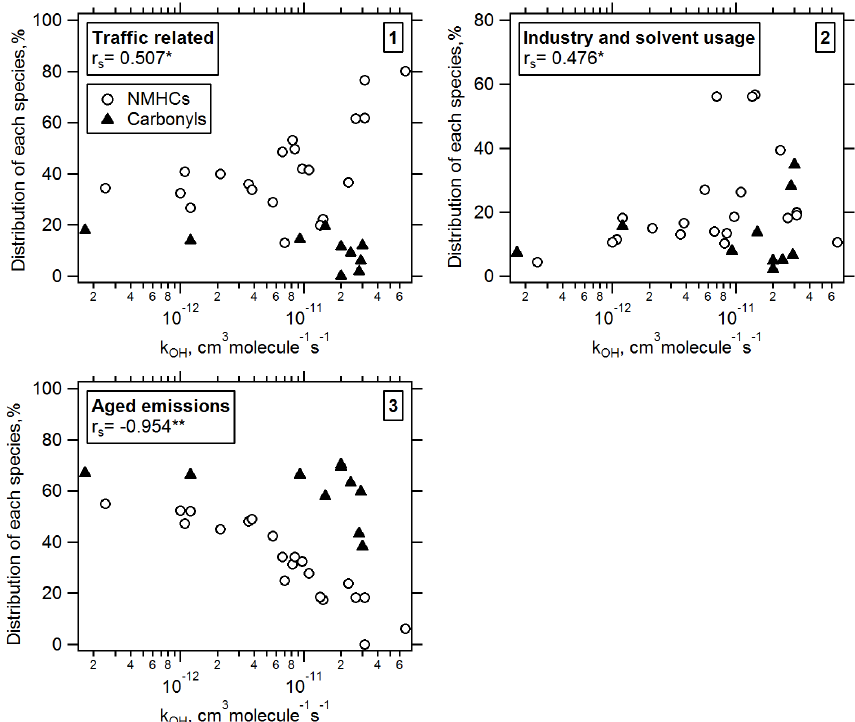
Fig. 3. Relationships between the factor contributions to each NMHC species and k OH values for NMHC species in summer. Each circle represents one compound. Carbonyls are shown as solid triangles in the graph, but they were not used for correlation analysis due to their secondary production. ∗ indicates a significant correlation at a confidence level of 0.05. ∗∗ indicates a significant correlation at a confidence level of